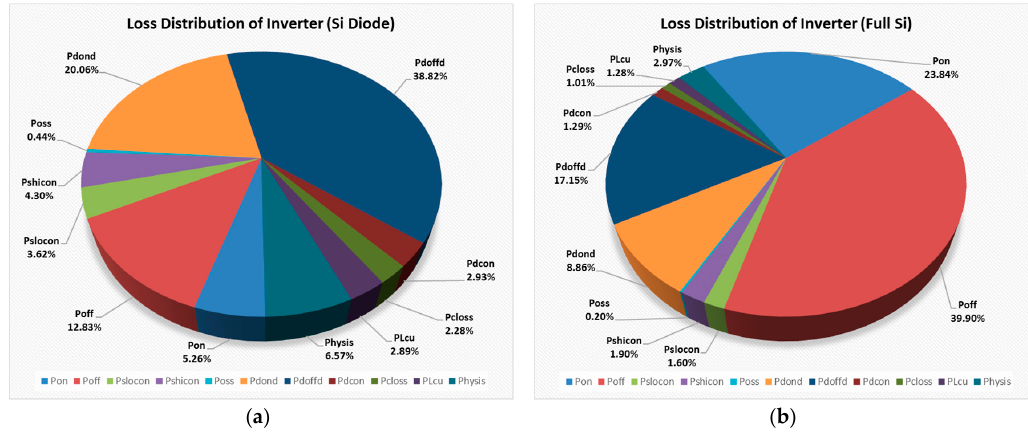
Figure 9. Loss comparison between calculation examples.